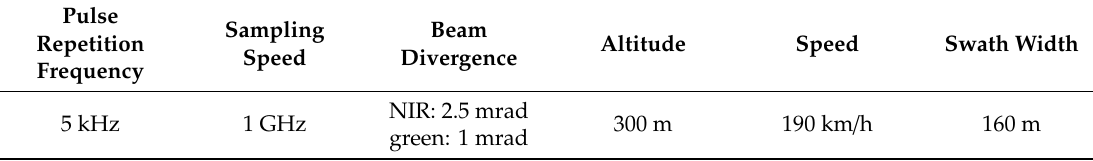
Table 1. Field data acquisition